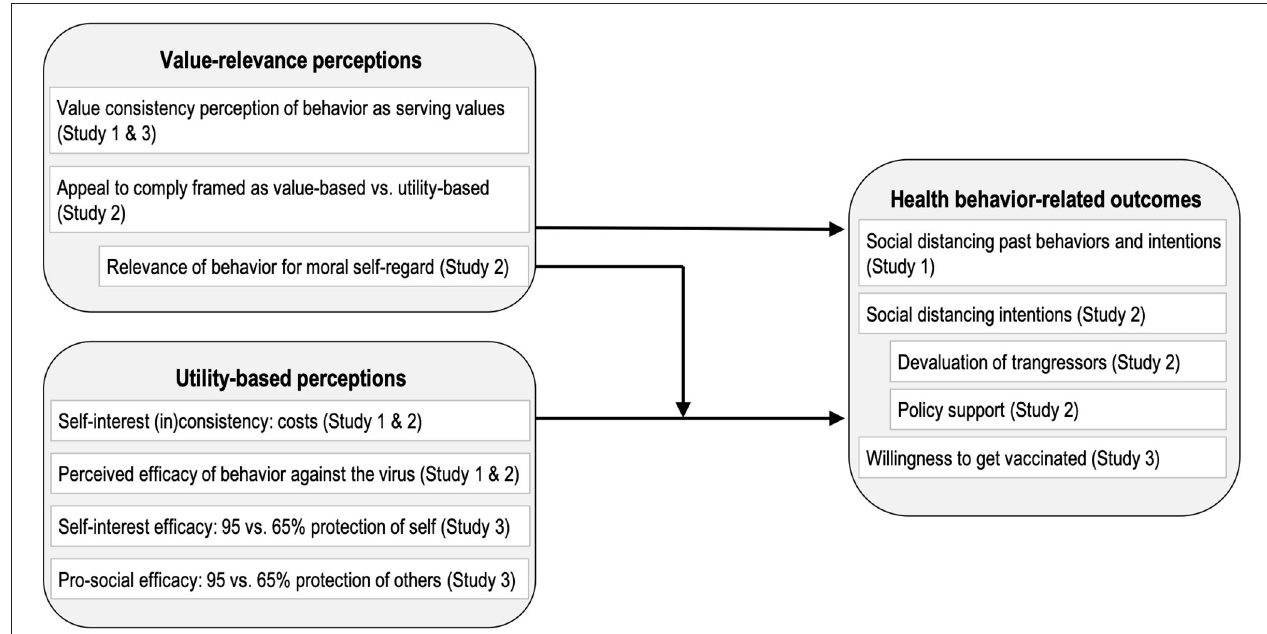
FIGURE 1 | Overview of the research model and variables. Indented boxes display exploratory measures. Across studies, this study predicted that value-relevance perceptions moderate the extent to which utility-based perceptions explain health behavior-related outcomes.